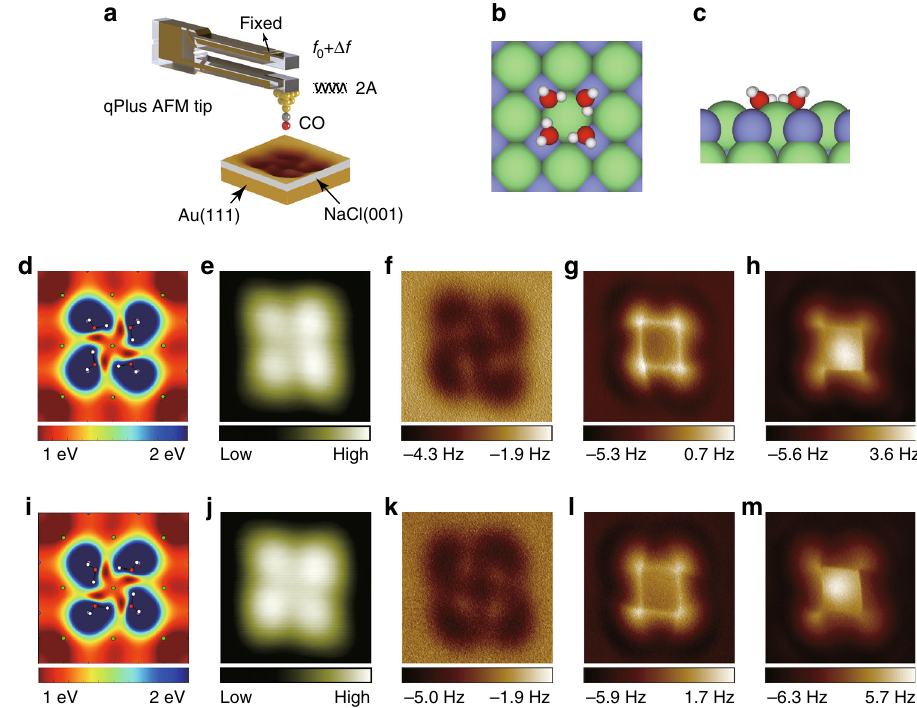
Fig. 1 Experimental set-up and AFM images of two degenerate water tetramers with a CO-terminated tip. a Schematic of a qPlus-based nc-AFM with a CO- tip. The cantilever oscillates at an amplitude of A and the tip-sample force-induced frequency shift of the cantilever from its natural resonance frequency ( f 0 ) is Δ f . b , c Top and side view of the water tetramer adsorbed on the NaCl(001) surface, respectively. H, O, Cl, and Na atoms are denoted as white, red, green, and purple spheres, respectively. d – h , i – m Water tetramers with clockwise and anticlockwise H-bonded loops, respectively. d , i Calculated electrostatic potential map of the water tetramers in a plane 60 pm above the outermost H atom. e , j Constant-current STM images acquired at (100 mV, 20 pA) and (100 mV, 30 pA), respectively. f , k , g , l , h , m Experimental Δ f images recorded at the tip heights of 100 pm, 10 pm, − 40 pm, respectively. The tip height is referenced to the STM set point on the NaCl surface (100 mV, 50 pA). The oscillation amplitude is 100 pm. The STM/AFM imaging was done on two different tetramers with two different CO-tips. The size of the images is 1.2 nm × 1.2